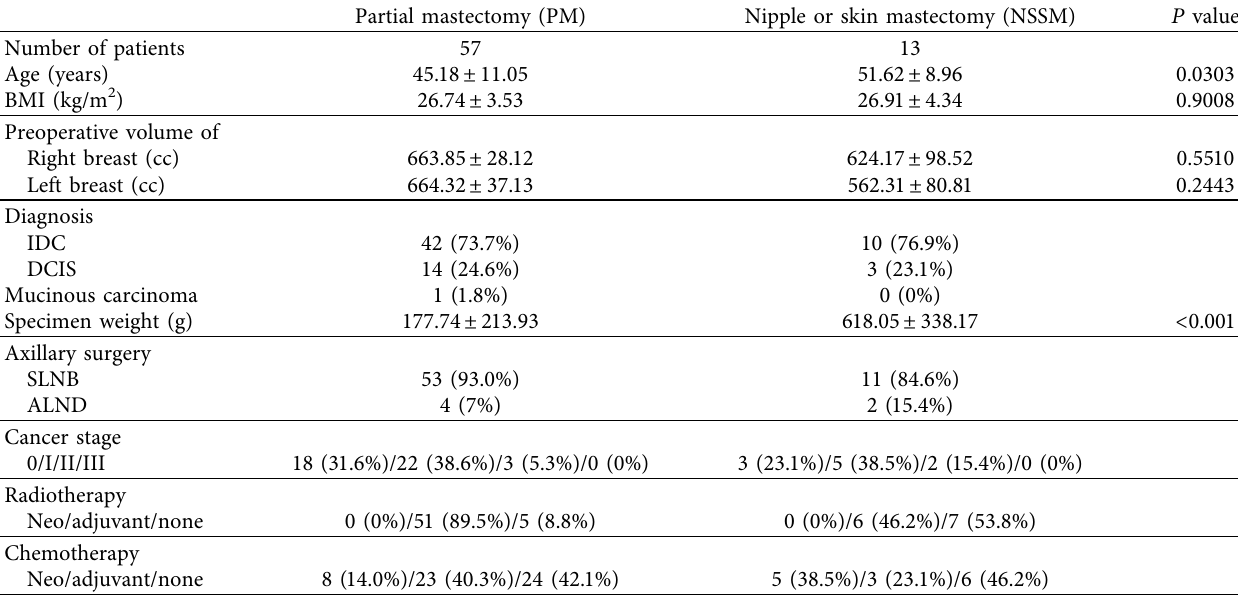
Table 1: Patient demographics.